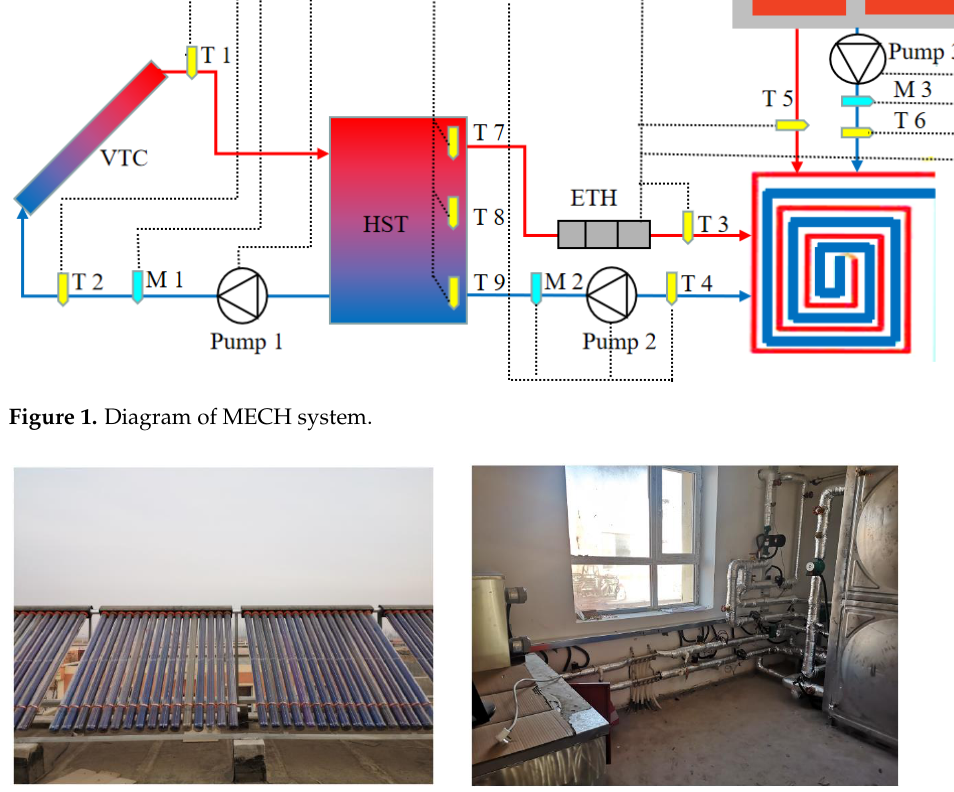
Figure 2. Equipment constituting MECH system: ( a ) VTC and ( b ) system pipeline.